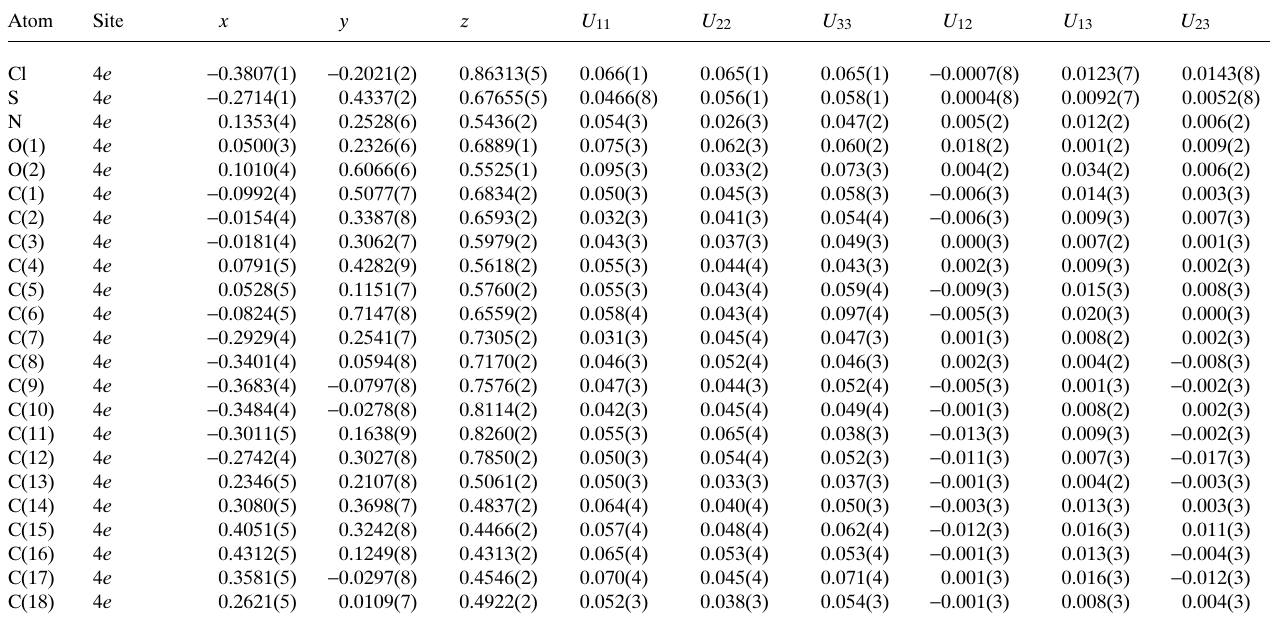
Table 3. Atomic coordinates and displacement parameters (in Å 2 ) .